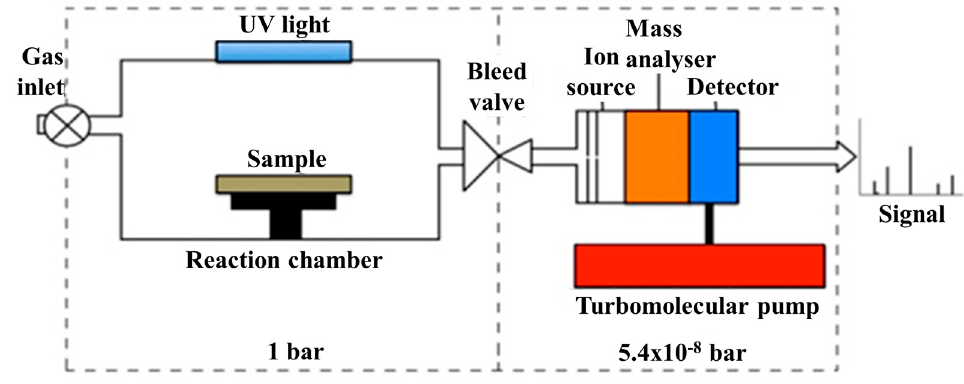
Figure 1. Schematic of the instrument for photo-catalytic activity.